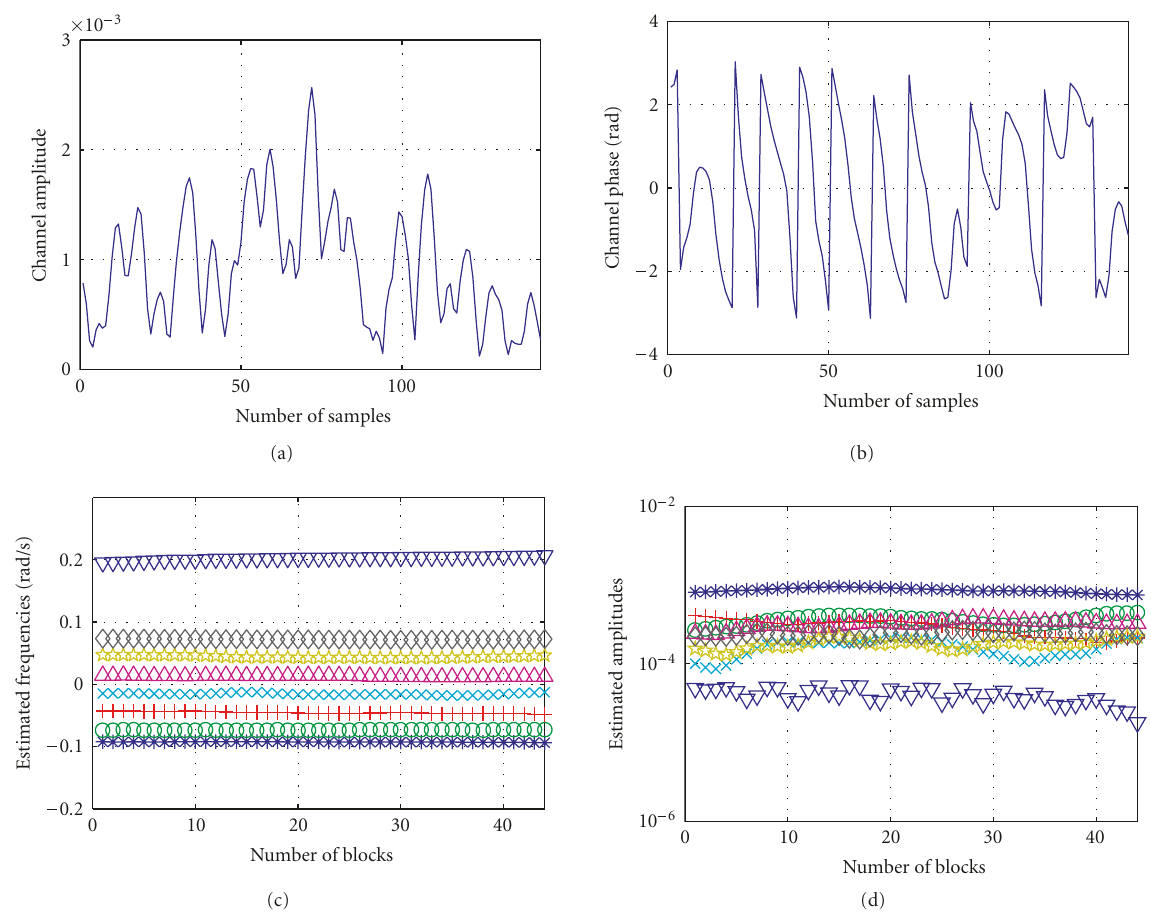
Figure 4: Example of the time variation of model parameters in an urban area: (a) the channel amplitude, whose dynamic range is large in this example; (b) the phase of the channel, which is linear in a part of this measurement; (c) the estimated frequencies of the sinusoids in each block, the number of sinusoids is assumed to be 8; (d) the amplitudes of the sinusoids associated to the frequencies in (c).